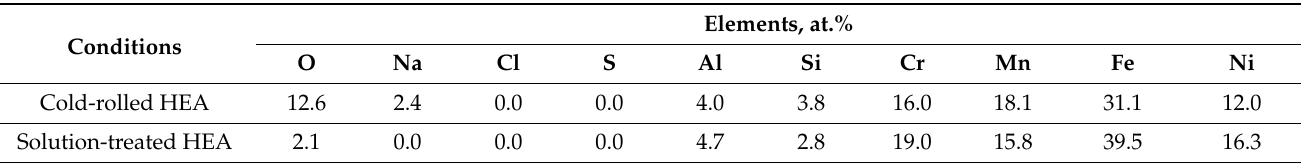
Figure 8. SEM surface morphologies of the Fe 36 Mn 20 Ni 20 Cr 16 Al 5 Si 3 HEA ( a , c ) cold-rolled, and ( b , d ) solution-treated conditions after subjected to 0.6 M NaCl solution. Table 2. EDX analysis of the corrosion products on the surface of cold-rolled and